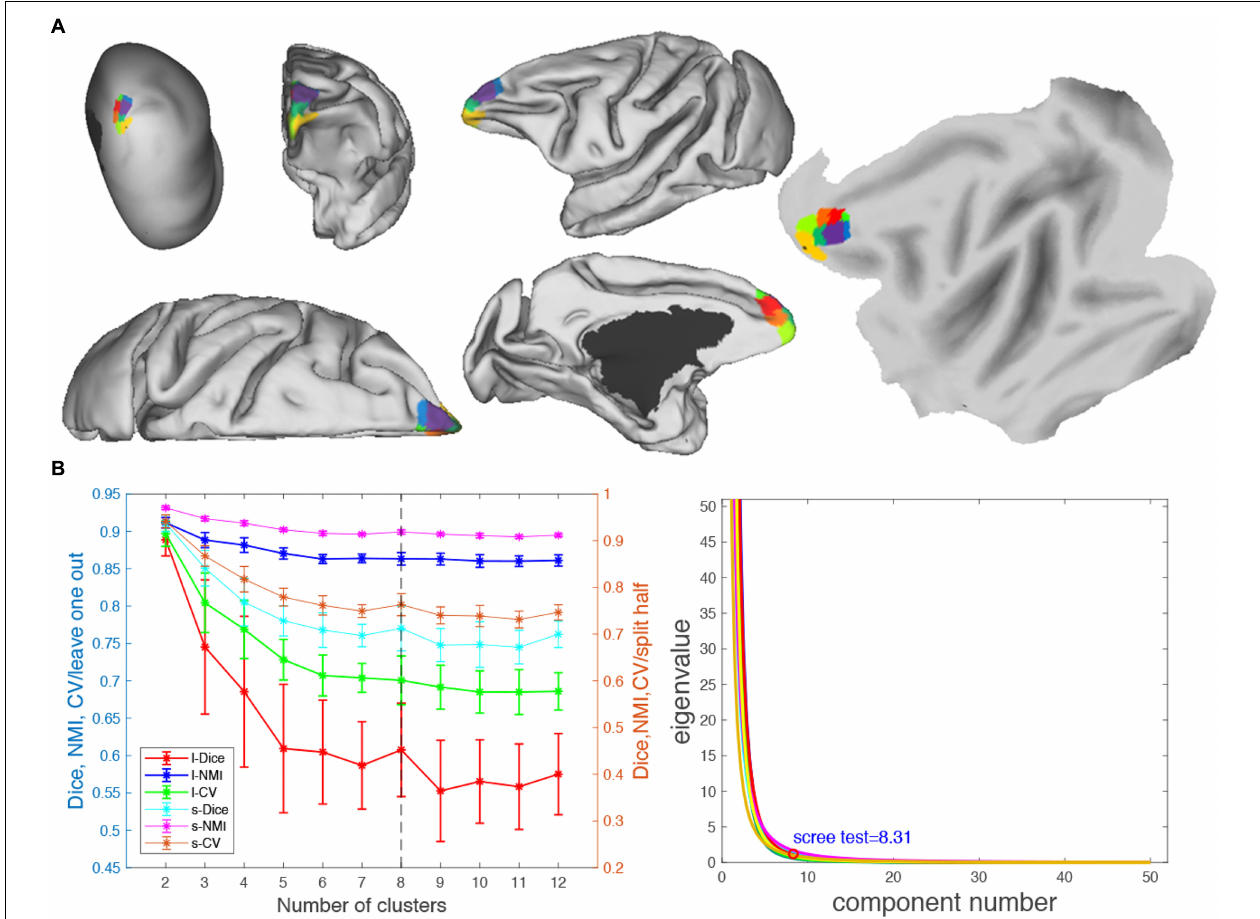
FIGURE 7 | Parcellation results of left frontal pole (FP.L). (A) The MPMs of FP.L with 8 clusters in flat, fiducial (lateral, medial, anterior, superior) surface, very inflated (dorsal-lateral) view. (B) Validity indices of the parcellation results for FP.L. Thereinto, the results of Dice, NMI, and cross-validation (CV) using leave-one-out (l-Dice, l-NMI, and l-CV) and spilt-half (s-Dice, s-NMI, and s-V) resampling technique (left), and PCA (right) suggest that the optimal result of eight clusters seems the most reasonable. The error bars represent standard